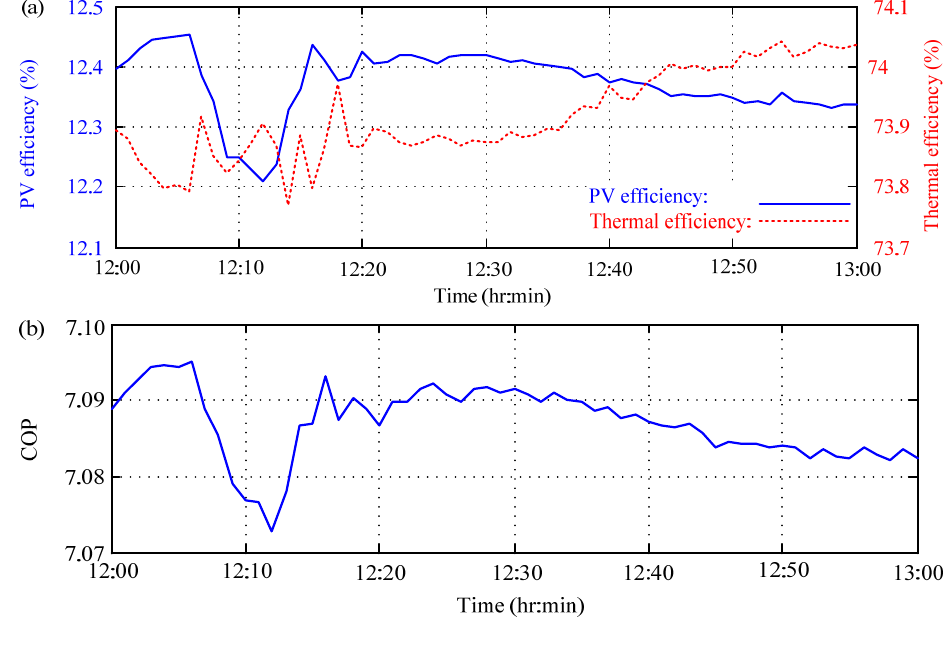
Figure 9. Performance analysis of PVTA-HPWH system on a mostly sunny day (12 June 2013): ( a ) PV and thermal efficiency; ( b )